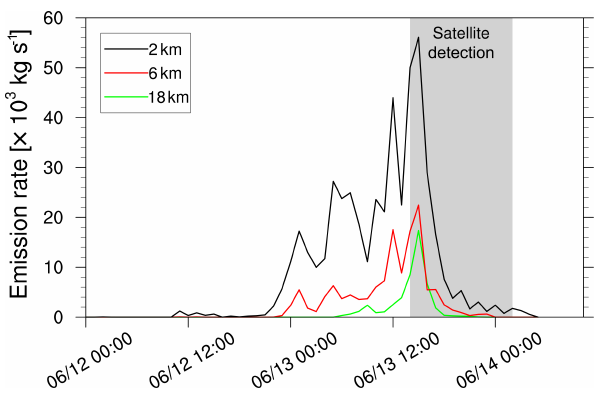
Figure 11. Time series for the emission rate (spatially integrated) driven by meteorological inputs at different horizontal resolutions (2, 6, and 18km). The dust flux is remarkable sensitive to friction velocity resolution. The gray-shaded area represents the time win- dow with satellite detection of airborne dust. According to simula- tions, the emission occurred before satellite